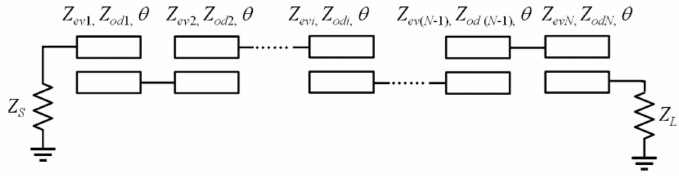
Figure 2. Topology of conventional N − section IT